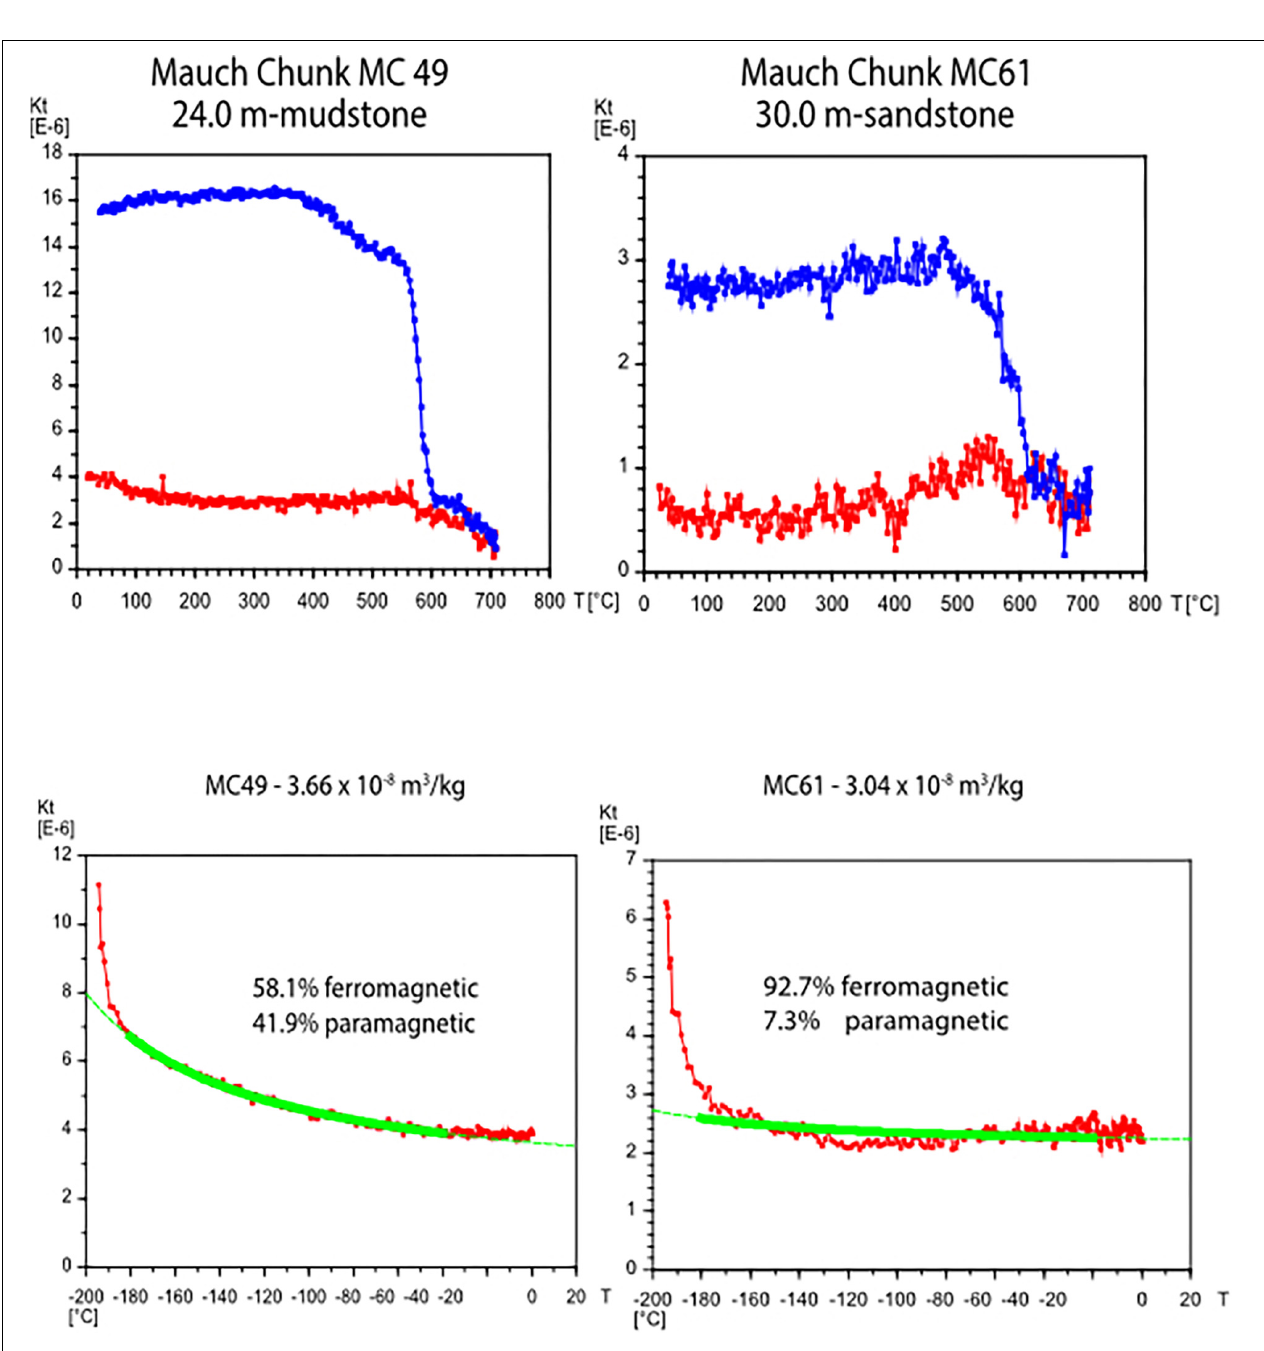
FIGURE 9 | High and low temperature MS vs. T results measured on the Kappabridge for a sample representative of a mudstone lithology and a sandstone lithology. The low temperature results are fit by a paramagnetic hyperbola to determine the relative proportion of ferromagnetic and paramagnetic contributing to the magnetic susceptibility (Hrouda,